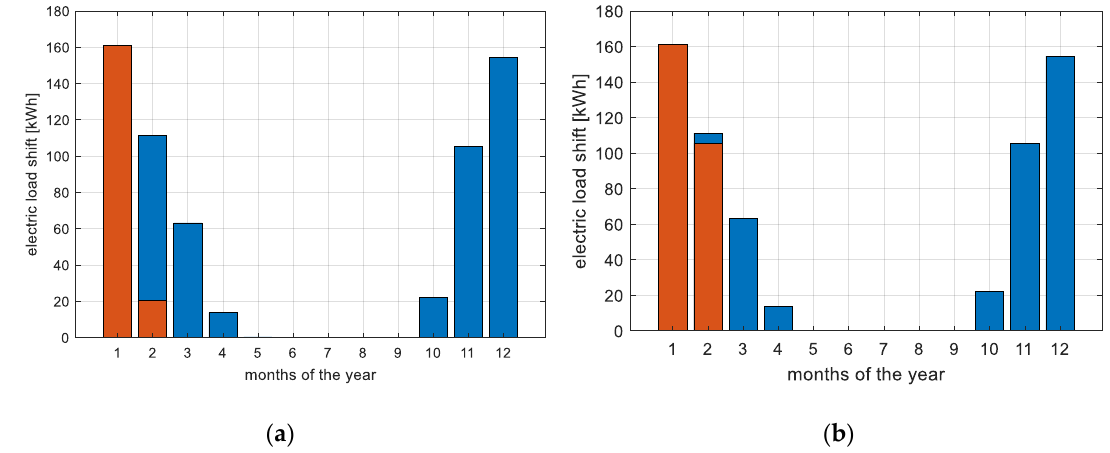
Figure 6. Electric load shift of heat pump operation with storage. With limited (red) and unlimited (blue) storage capacity for: ( a ) base case with 720 h of excess electricity and ( b ) case with 1080 h of excess electricity available.